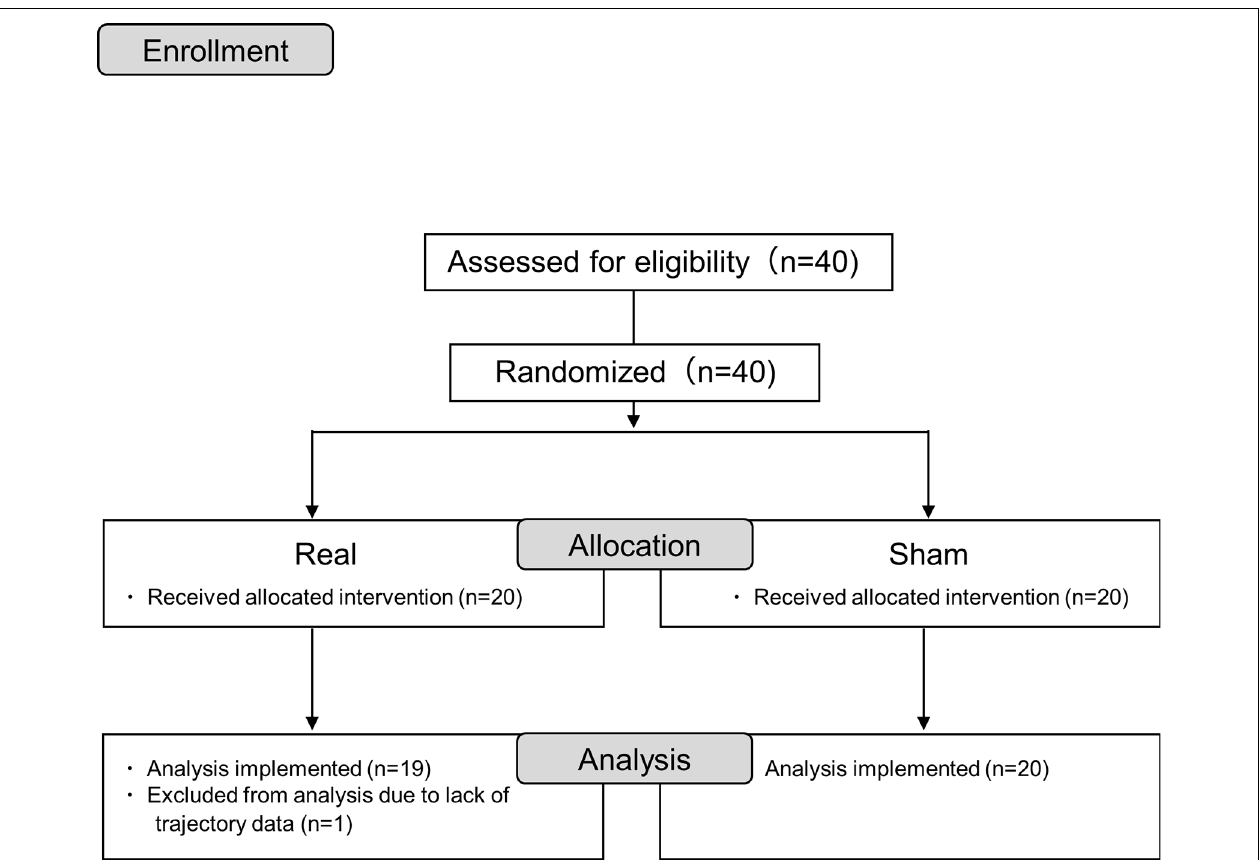
FIGURE 2 | Consort flow